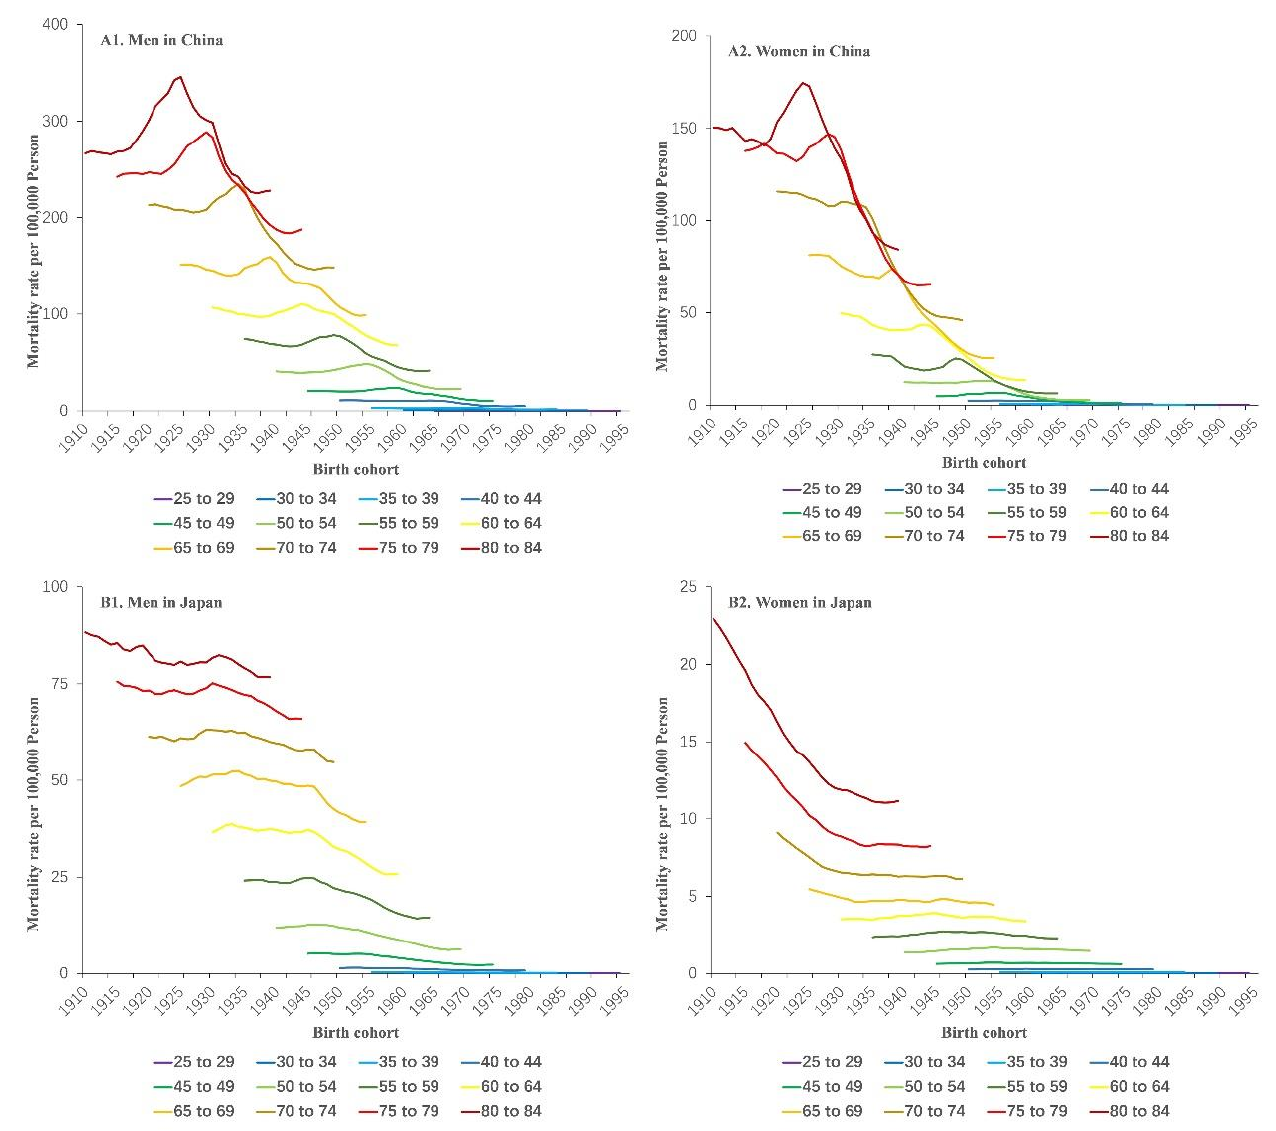
Figure 3. Cohort-specific mortality rates of esophageal cancer by age and sex in China ( A1 , A2 ) and Japan ( B1 , B2 ), 1990 to 2019. Data on esophageal cancer mortality were arranged into 18 successive birth cohorts, which include those born between 1910–1914 (median, 1912) and 1990–1994 (median, 1992), and 12 age groups between 20–24 (median, 22 years) and 80–84 years of age ( p < 0.01 for